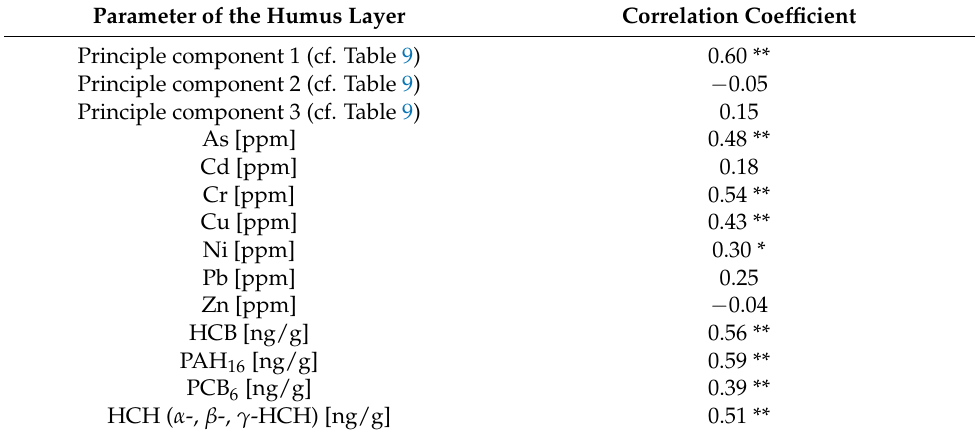
Table 10. Correlation coefficients between the pollutant concentration of the humus layer and the estimated Ca deposition from the NFSI plots for the reference year 1988 (kg/ha/a); significance: * p < 0.05, ** p < 0.01.